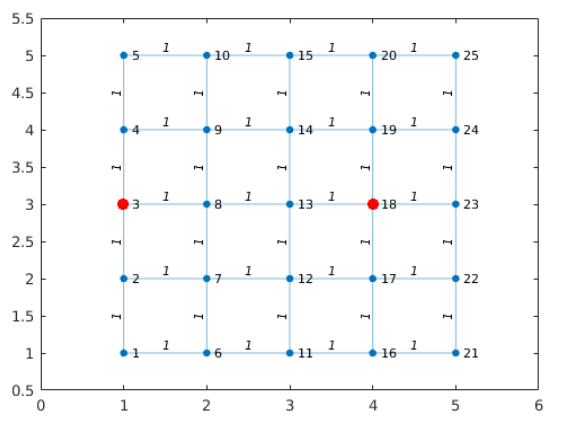
Figure 2. Test case for a 5 × 5 grid plan and best WU location.